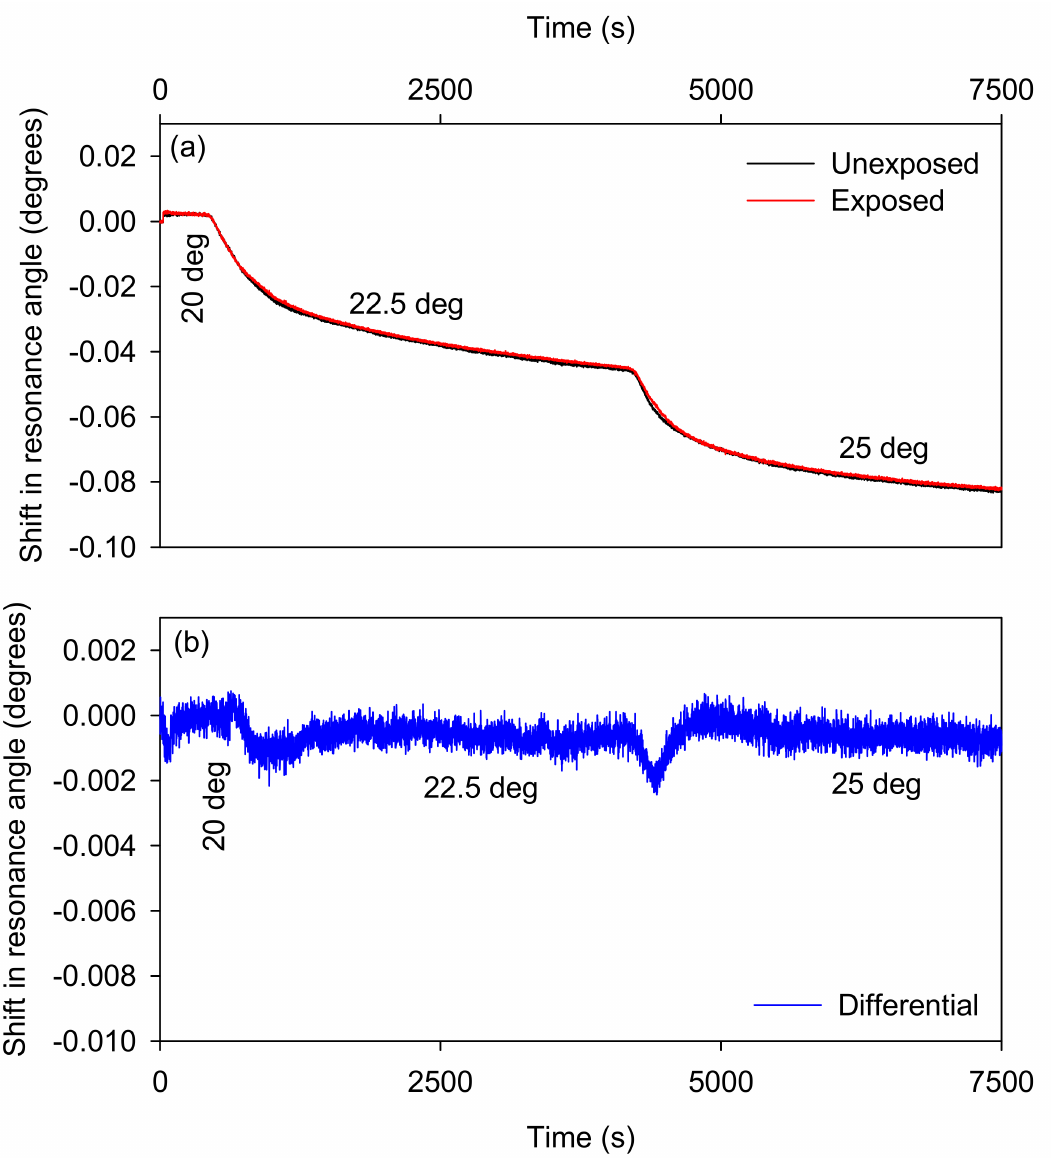
Figure 6. ( a ) Absolute and ( b ) di ff erential shifts in the resonance angles of the self-referenced di ff raction-based LW when the system temperature was